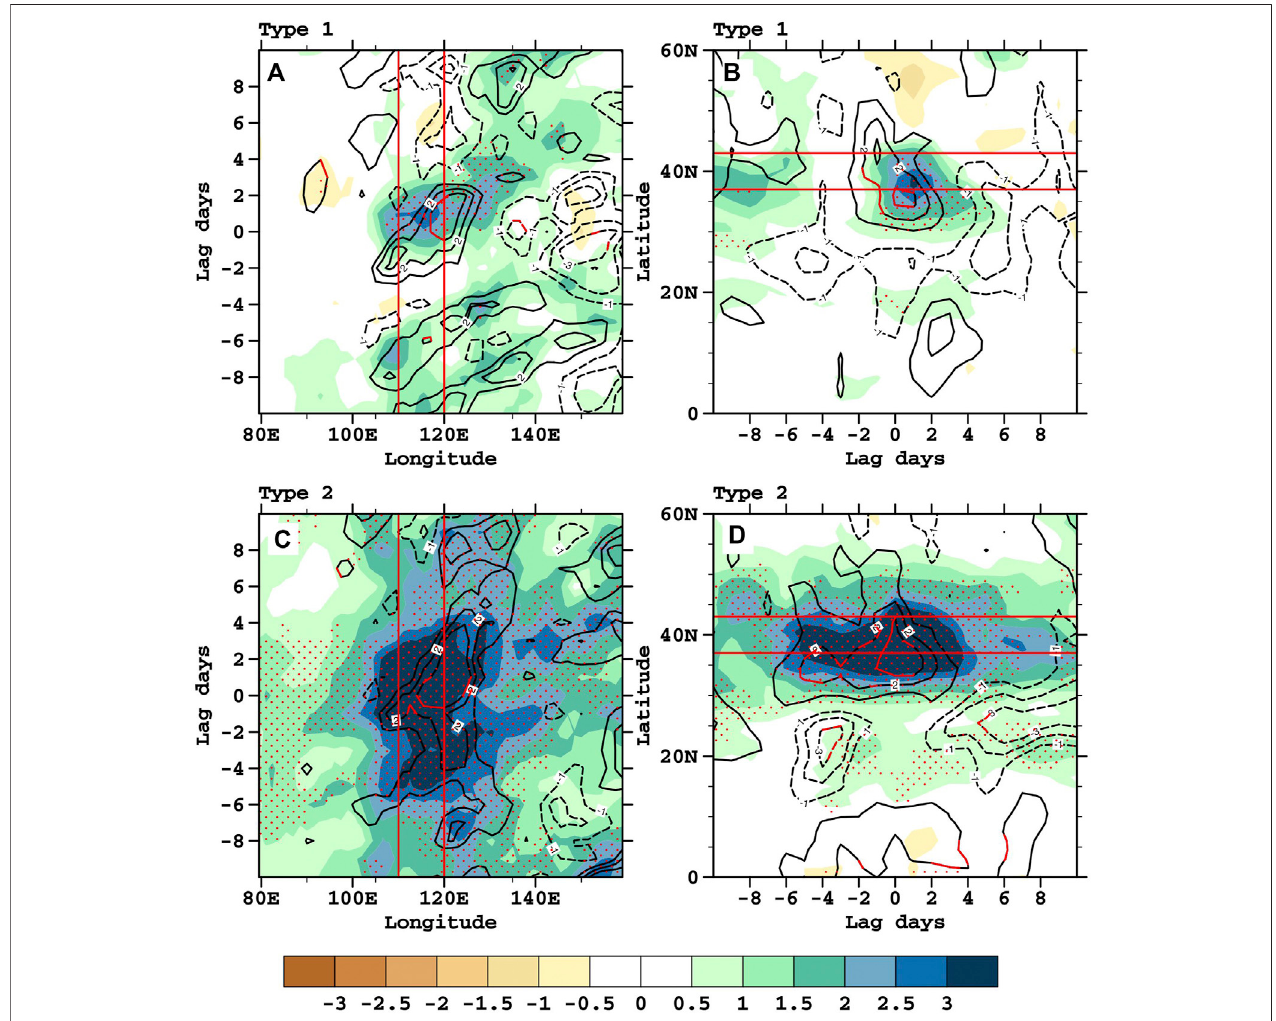
FIGURE 7 | Time-longitude cross sections of mean meridional wind anomalies (contour, unit: m · s − 1 ) and speci fi c humidity anomalies (shading, unit: g · kg − 1 ) at 850 hPa over 37 – 43N of type 1 (A) and 2 (C) PEPEs, Time-latitude cross sections of mean meridional wind anomalies (contour, unit: m · s − 1 ) and speci fi c humidity anomalies (shading, unit: g · kg − 1 ) at 850 hPa over 110-120E of type 1 (B) and 2 (D) PEPEs, lag days equals -8 (8) means 8 days prior to (after) the onset of PEPEs. Red contour and dotted areas indicate a 95% con fi dence level. Red boxes indicate the longitude and latitude range of North China.